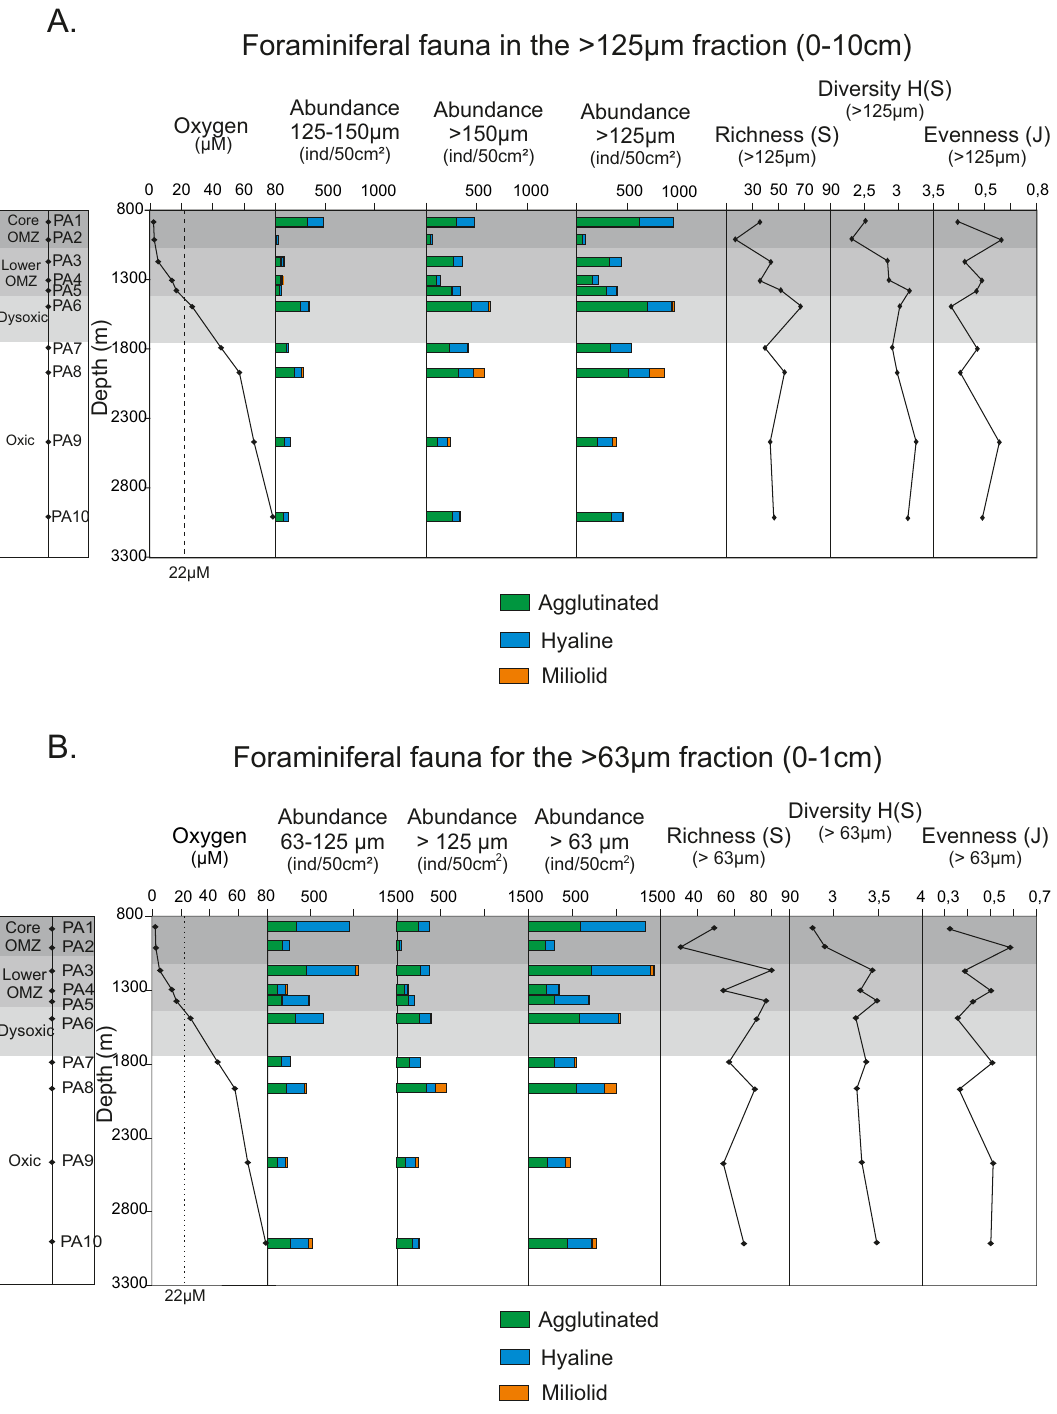
Fig. 3. (A) Live (Rose Bengal stained) foraminiferal abundances (ind/50cm 2 ) in the 125–150µm, > 150µm and > 125µm fraction for the entire core (0–10cm) and foraminiferal biodiversity indices (in the > 125µm fraction) along the sampling transect. The dashed line at 22µM corresponds to the definition of the OMZ according to Levin et al. (2003). (B) Live foraminiferal abundances (ind/50cm 2 ) in the 63–125µm, > 125µm, > 63µm fractions for the first cm (0–1cm) of the sediment and foraminiferal biodiversity indices (in the > 63µm fraction) along the sampling transect. The dashed line at 22µM corresponds to the definition of the OMZ according to Levin et al.